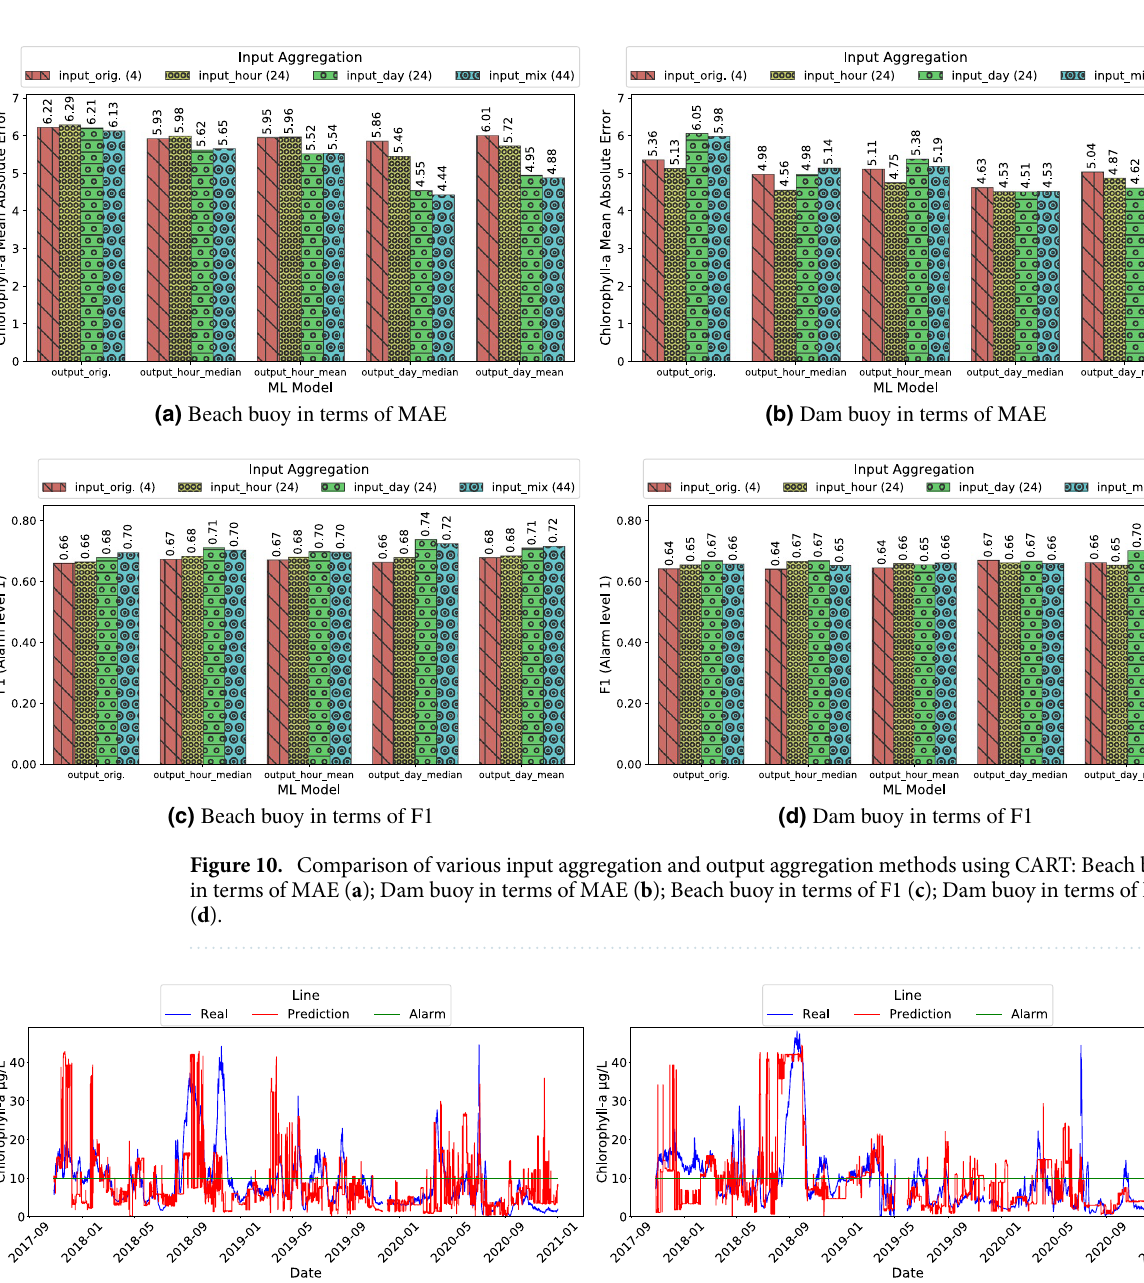
Figure 11. Line plots of Chl- a and CART predictions (time is shown in x-axis and the Chl- a value in y-axis), with the input aggregated over a day (input_day) for both buoys and using the median of Chl- a computed over a day (output_day_median) as output for Beach buoy ( a ) and the mean of Chl- a computed over a day (output_ day_mean) for Dam buoy ( b